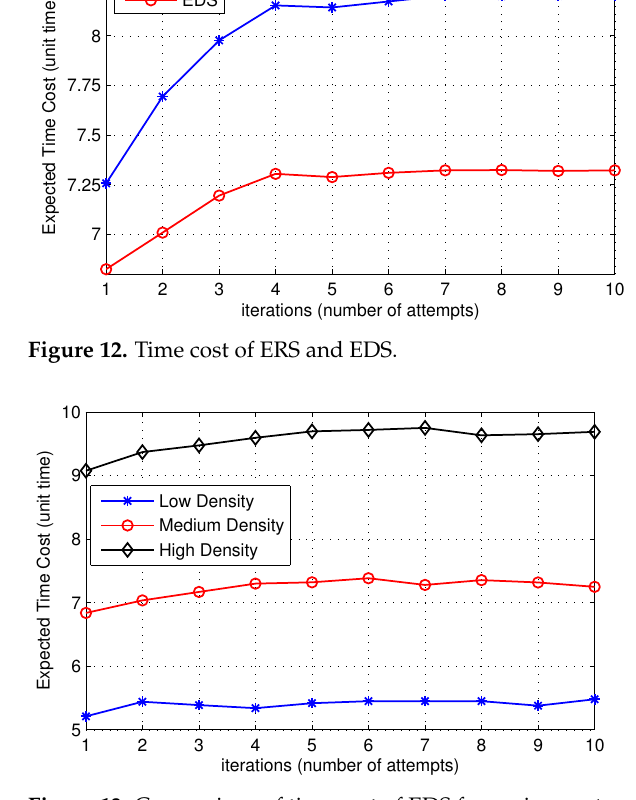
Figure 13. Comparison of time cost of EDS for various network densities.